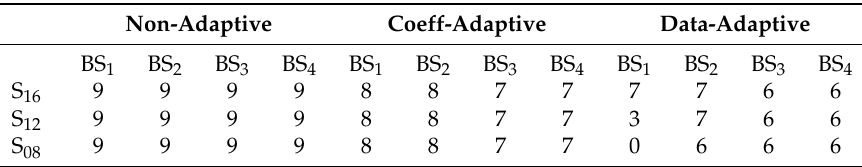
Table 4. Scaling positions of the barrel